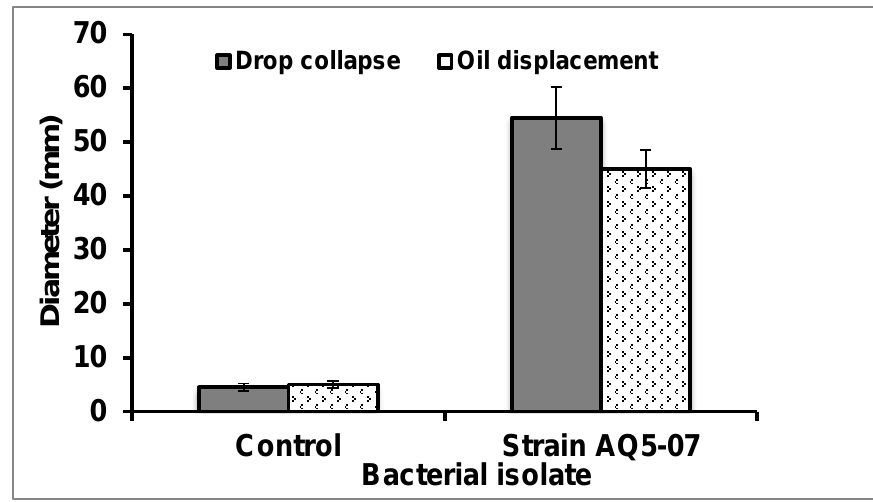
Figure 1. Drop collapse and oil displacement tests for supernatant fraction from Rhodococcus erythropolis AQ5-07 culture incubated for 72 h. Error bars represent mean ± standard deviation, 𝑛 = 3.